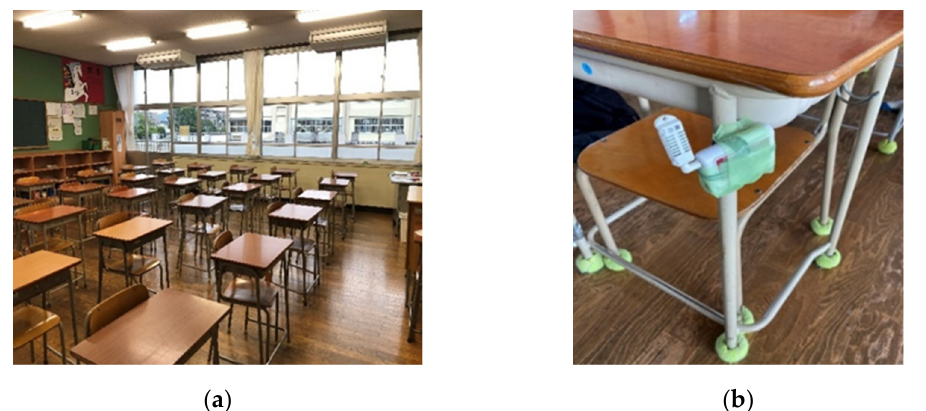
Figure 2. Field measurement condition ( a ) Inside a typical classroom of Oji Oita Junior High School and ( b ) the position of the measurement item, TR-72NW.